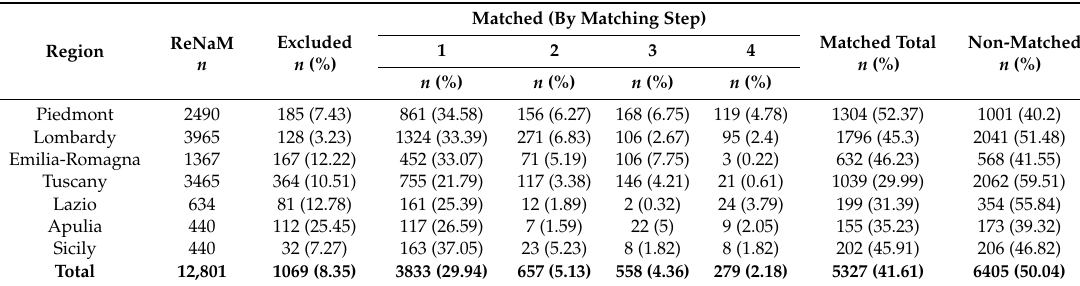
Table 3. The number of ReNaM records and results of the record linkage, by region. The results of linkage procedures were reported to distinguish between excluded (‘a priori’), non-matched, and matched: (1) Within subjects with more than one equal word in firm’s name, (2) two equal words, (3) one equal word in a string of length equal to one, (4) known